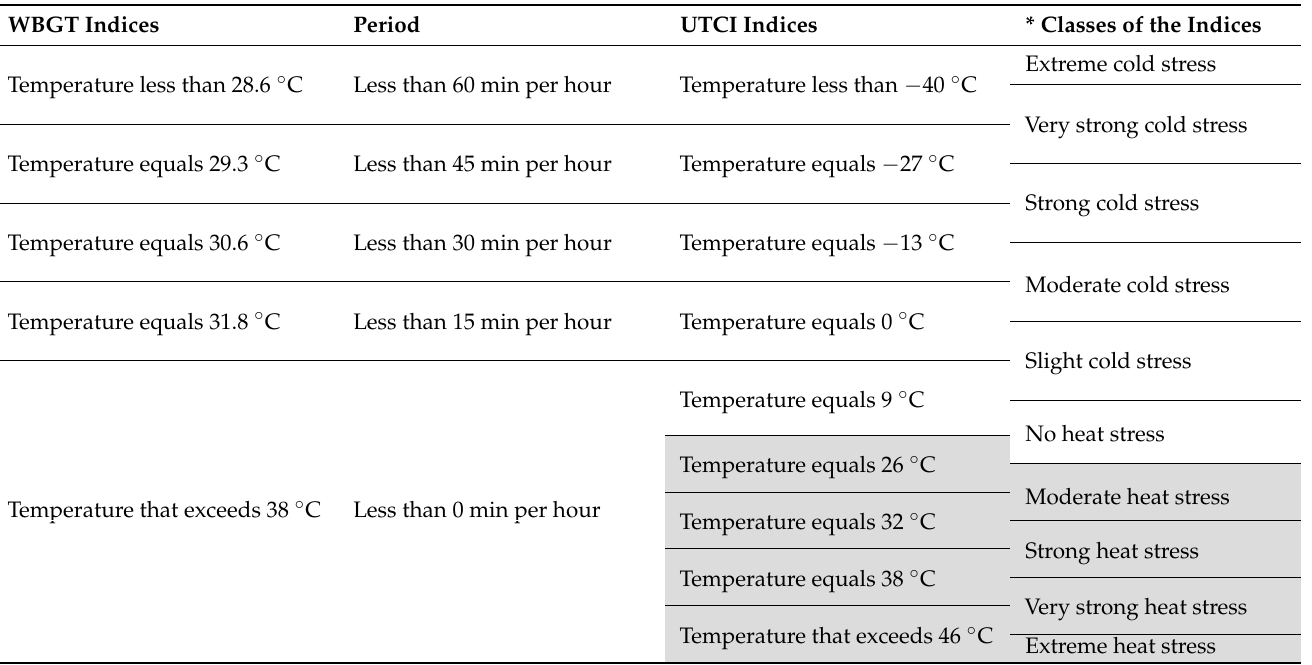
Table 2. Temperature bands and classes of thermal indices for WBGT and